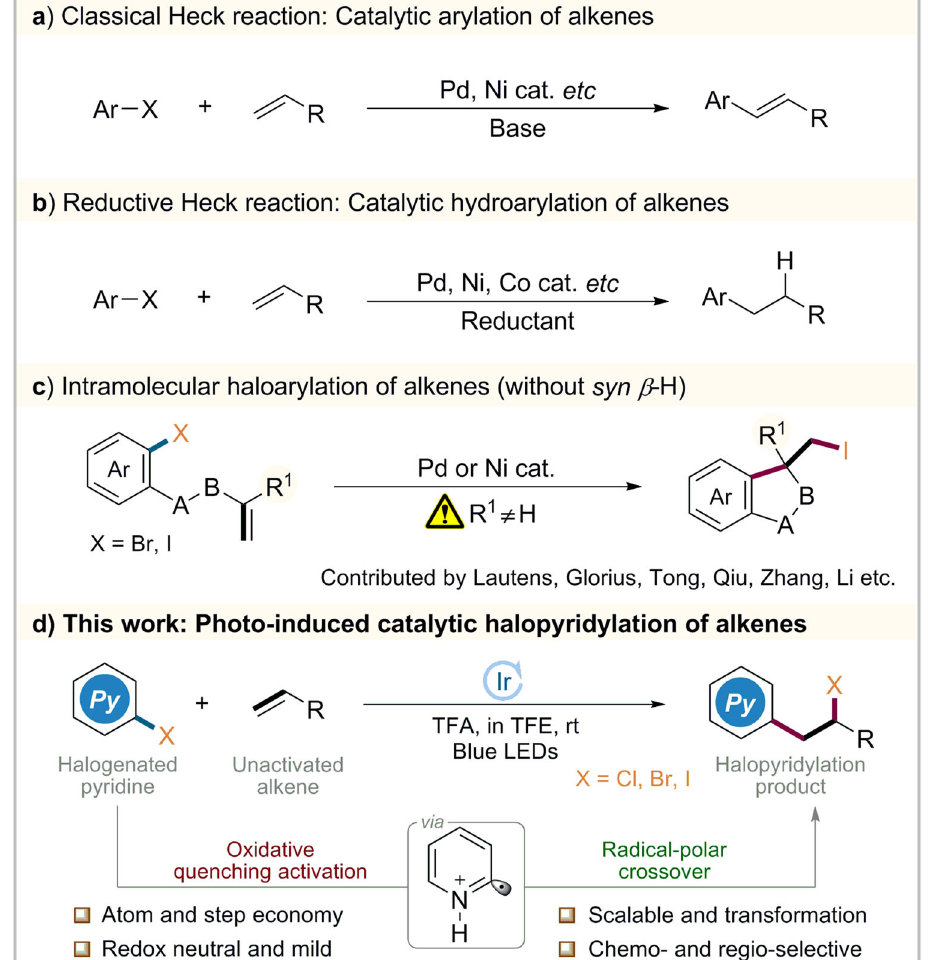
Fig. 1 Cross-coupling of aryl halides with alkenes. a Classical Heck reaction. b Reductive Heck reaction. c Intramolecular halo alytic halopyridylation of alkenes. d Photo-induced catalytic halopyridylation of